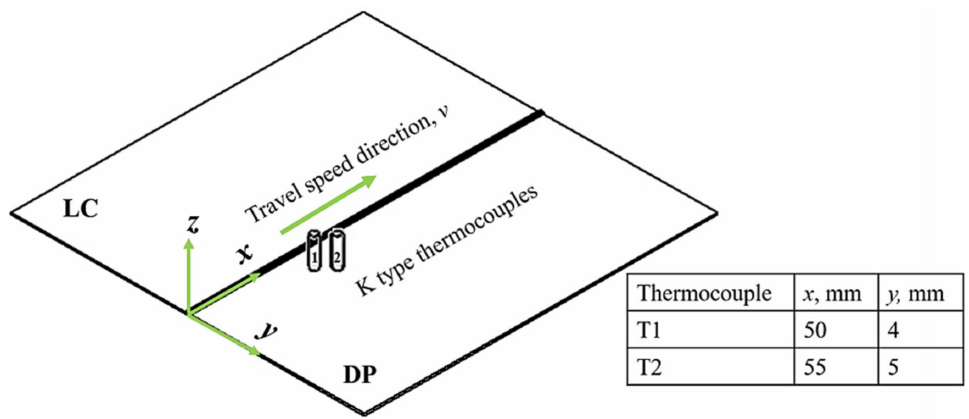
Figure 2. Thermocouples’ location for the experimental temperature measurements.